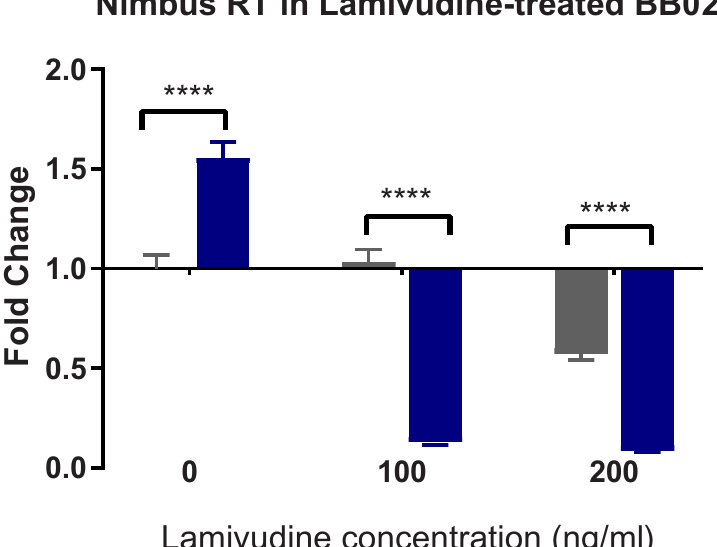
Fig 11. qPCR analysis of RNA from susceptible BBO2 juvenile snails unexposed (gray) or exposed (blue) for 2hr to S . mansoni miracidia. Histograms show expression of the nimbusRT encoding transcript in normal BBO2 snails (0) or those treated with RT inhibitor, lamivudine (100 ng/ml or 200 ng/m1). Note the upregulation of the nimbusRT encoding transcript in exposed control (0) snails and down regulation of this transcript in lamivudine-treated snails (exposed and unexposed) snails. Fold change was determined as described in MATERIALS and METHODS. Significant expression normalized against expression of the myoglobin encoding transcript was measured by 2-way ANOVA and is indicated by number of asterisks on each histogram where ���� , indicates the most significant